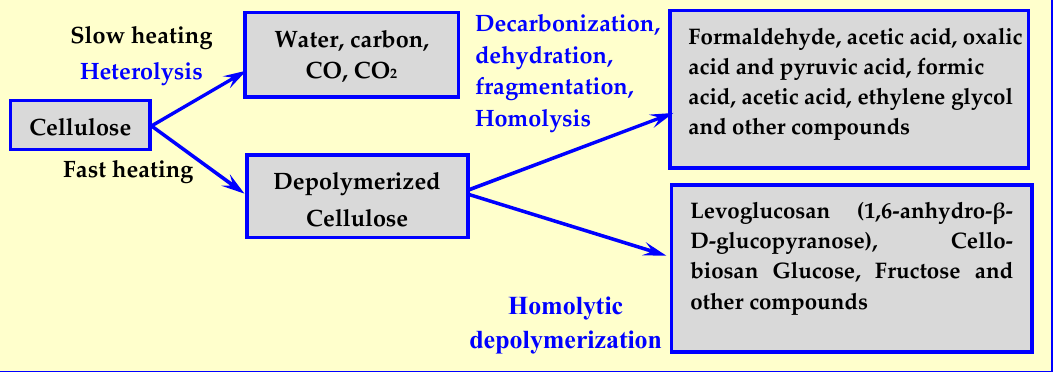
Figure 3. Influence of temperature increase rate on the composition of cellulose pyrolysis products [17].